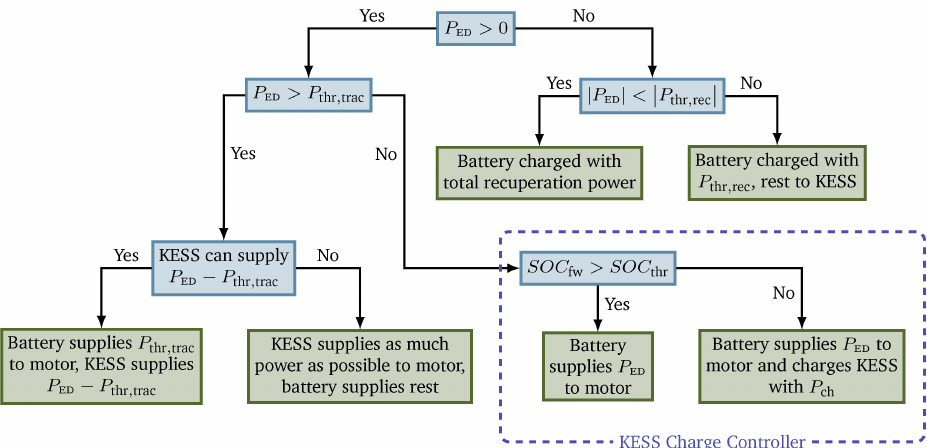
Figure 4. Flow-chart of the rule-based control